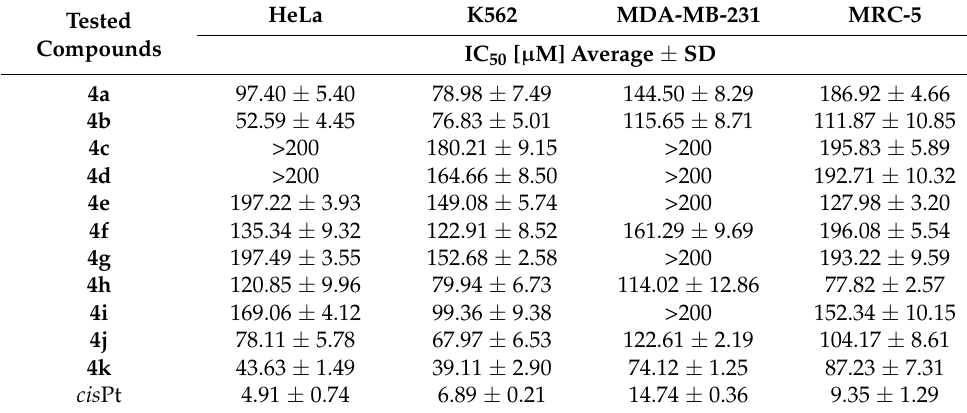
Table 5. Cytotoxic activity of compounds. Tested